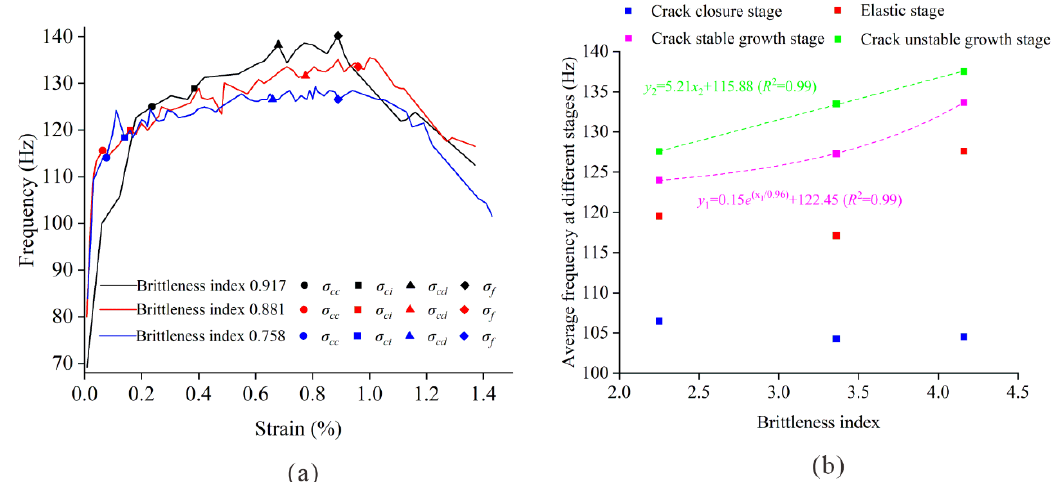
Figure 20. Variation analysis of the natural frequency: ( a ) natural frequency curves of specimens with different brittleness indexes and ( b ) relationship between the average natural frequency during different stages and the brittleness index.